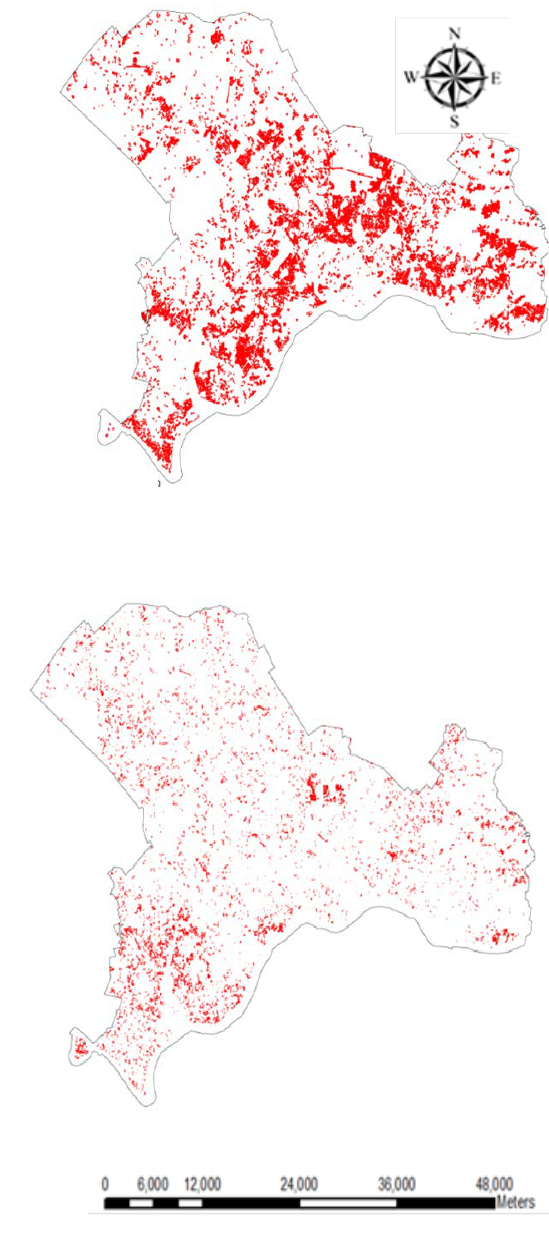
Figure 3. Forest cover in Iskandar Malaysia as detected in Landsat data 1990 (top panel) and 2010 (bottom panel).